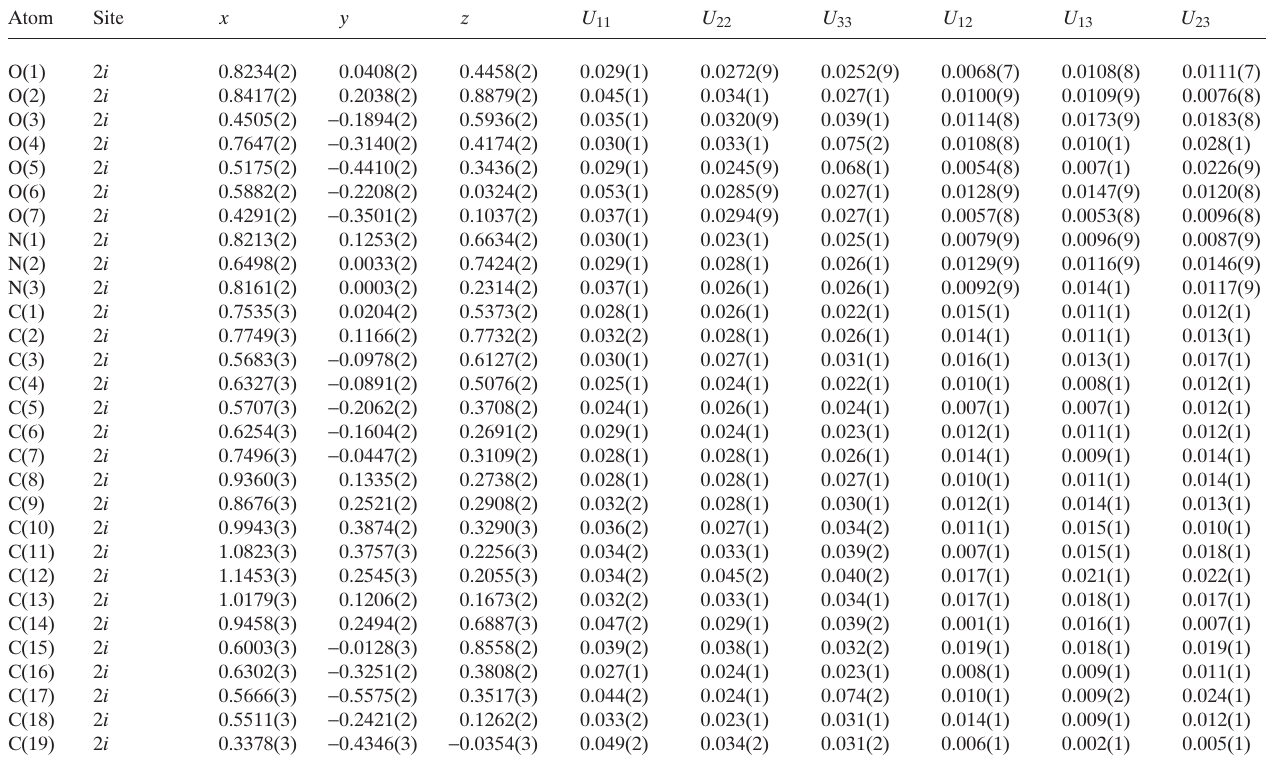
Table 3. Atomic coordinates and displacement parameters (in Å 2 )